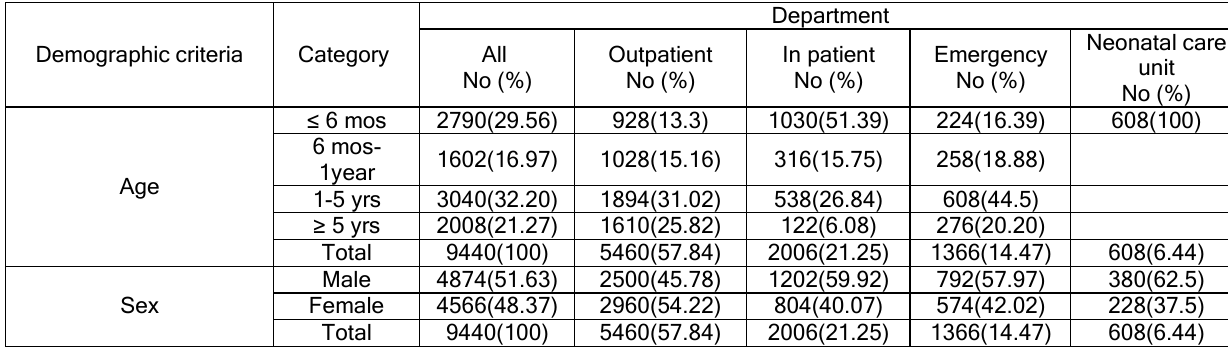
Table 1: Demographic characteristics of studied groups.